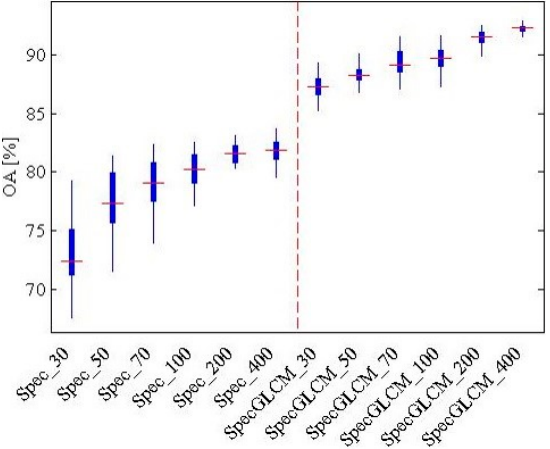
Figure 10. The accuracies of the land-cover classification for the USGS dataset with different features and samples. The underscore connects the feature and the number of samples of each class.